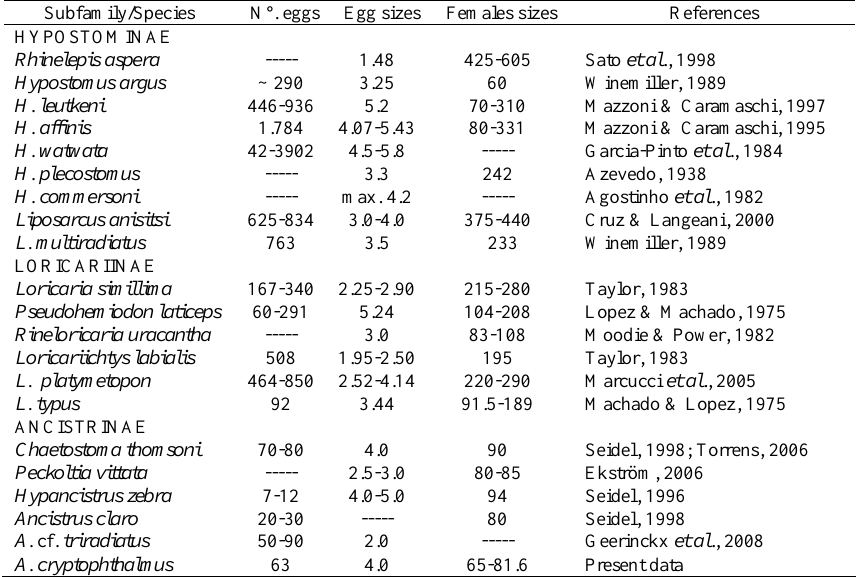
Table 1. Numbers of eggs per female, their diameter (mean values or observed range, in mm) and reported sizes (TL, in mm) of reproducing females recorded in the literature for epigean loricariids, compared to the presently observed values for